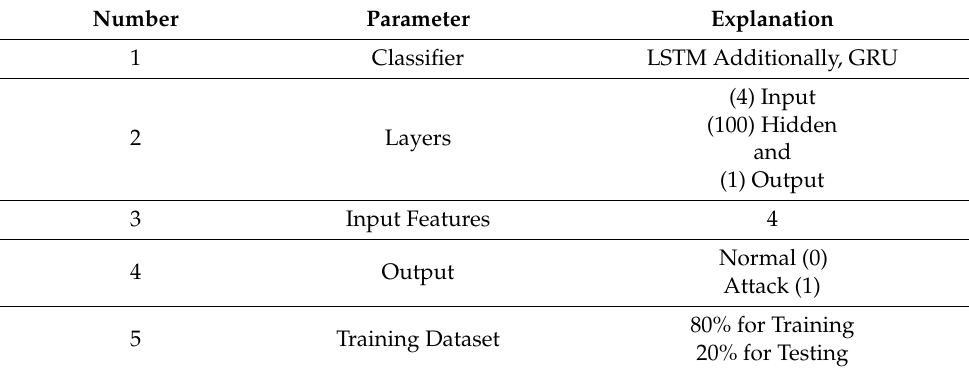
Table 3. LSTM and GRU classifier training parameters for Bot-IoT.